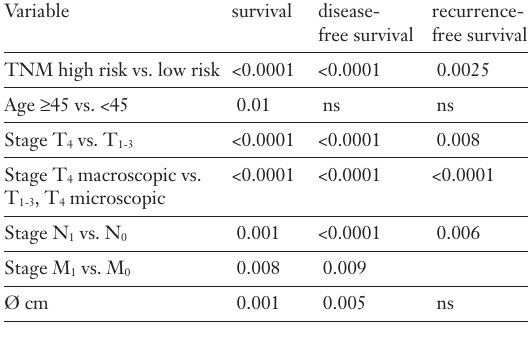
high-risk and in none of the 4 TNM low-risk pa- tients. Thus, there were 5 curable recurrences Figure 2a. Patients aged <45 yrs or those with CI (Table 2). Only 1/107 nodal recurrence was ob- alone had cumulative survival and disease-free sur- served in patients with a primary node negative tu- vival of 100% (Fig. 2b, Table 5). In univariate risk mour, vs. 5/36 with a pN tumour (p = 0.0004, log- 1 factor analyses grossly invasive tumour, stage pT rank test). In 3/83 patients without radical initial therapy a postoperative event occurred (1 death; nodal involvement, and tumour size had an adverse effect on survival and/or disease-free survival (Table 6). The adverse effect of 131 I clearly reflects patient selection.